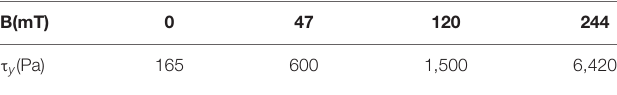
TABLE 2 | The dynamic yield stress of MRG-70 under different magnetic induction